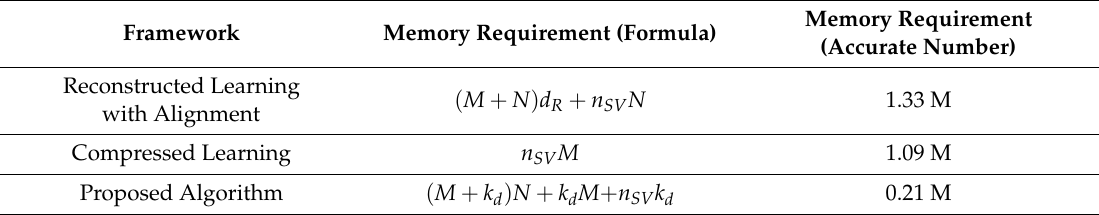
Table 5. Memory overheads of the different frameworks.